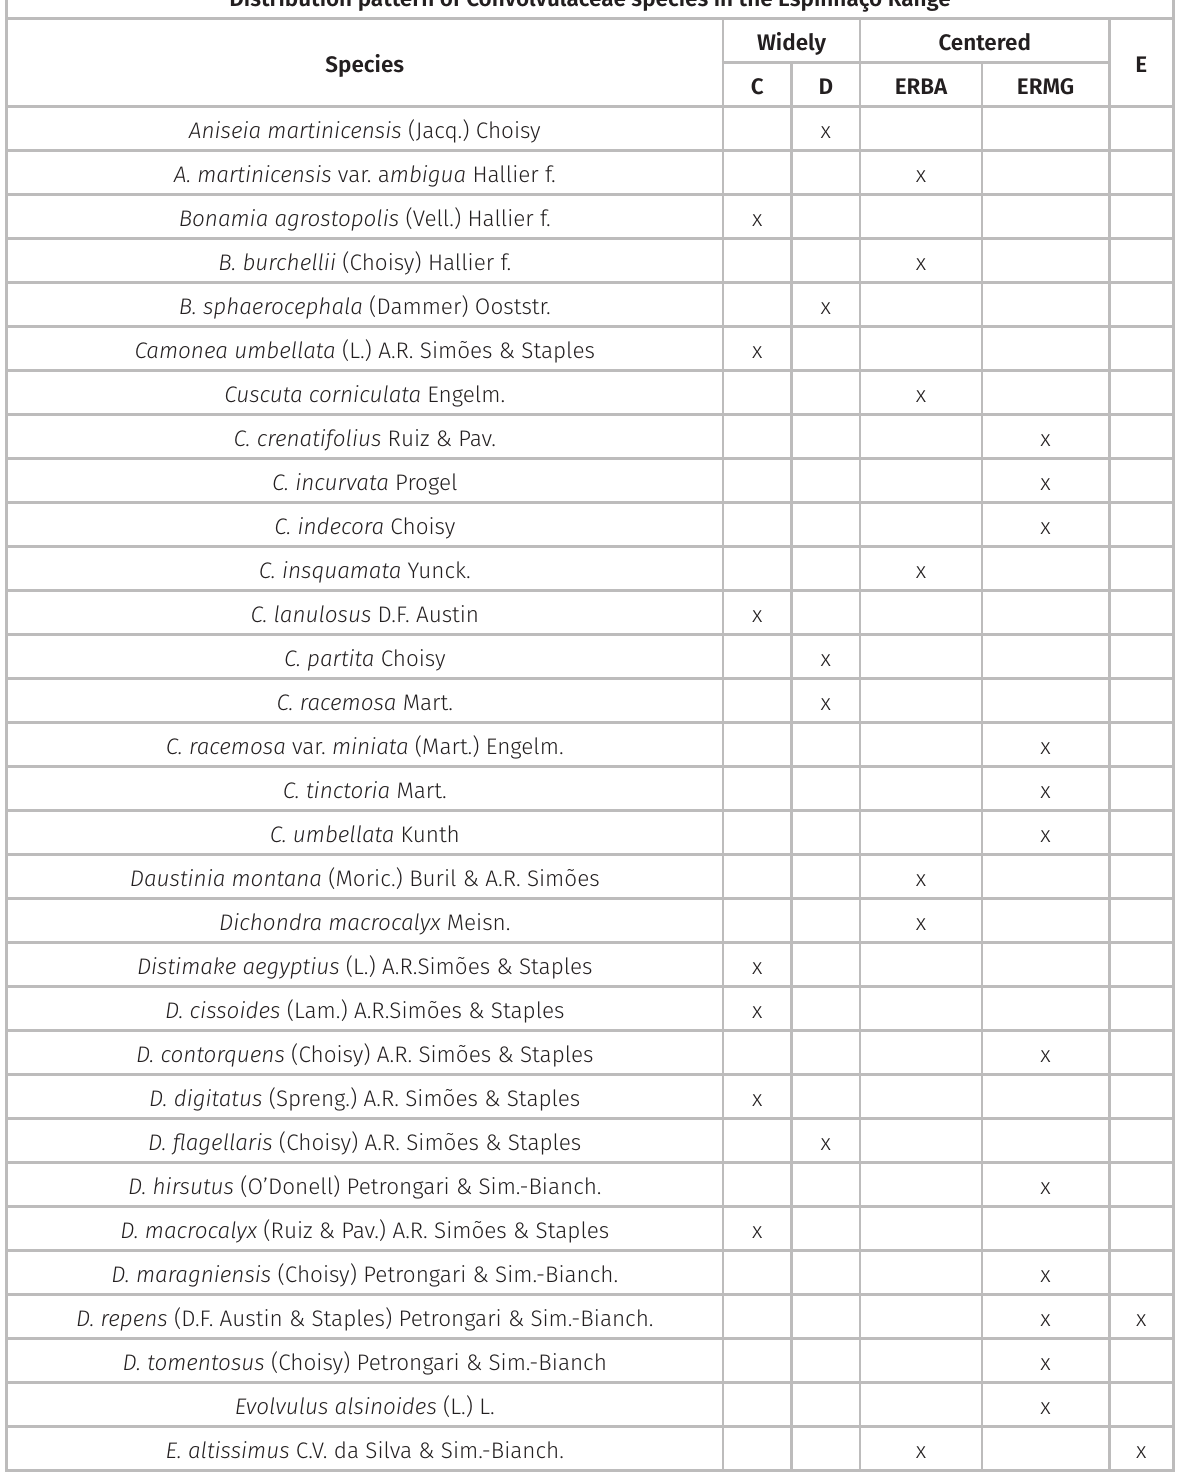
Widely Centered E C D ERBA ERMG